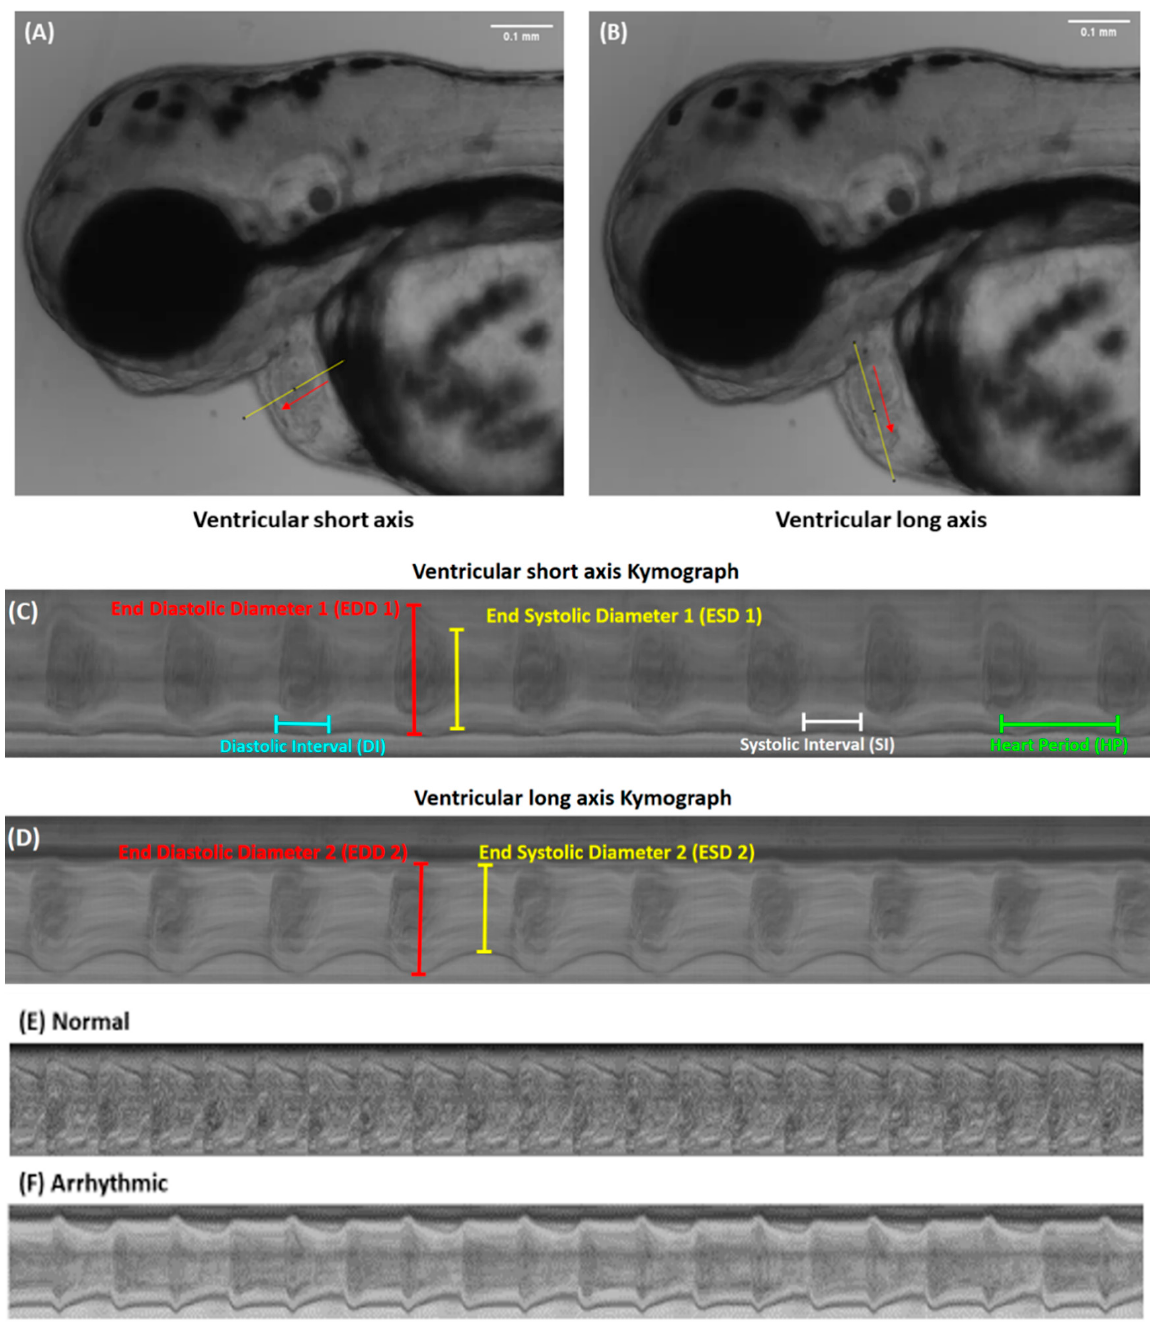
Figure 2. Cardiac physiology parameter endpoints in zebrafish aged at 72 h post-fertilization measured by kymograph method. The position for kymograph measurement as ( A ) short-axis of the ventricle and ( B ) long-axis of the ventricle (yellow line: line drawn in ImageJ, red arrow: direction of yellow line when drawn). The typical kymograph pattern obtained from the ( C ) short-axis and ( D ) long-axis of ventricle. Some important parameters like end diastolic diameter ( EDD , red color) and end systolic diameter ( ESD , yellow color), heart period (HP, green color), diastolic interval (DI, blue color), and systolic interval (SI, white color) from either short axis or long axis were presented with solid lines in different colors. The typical kymograph collected from ventricle (V) chambers of normal ( E ) and astemizole-induced arrhythmic ( F ) heart.